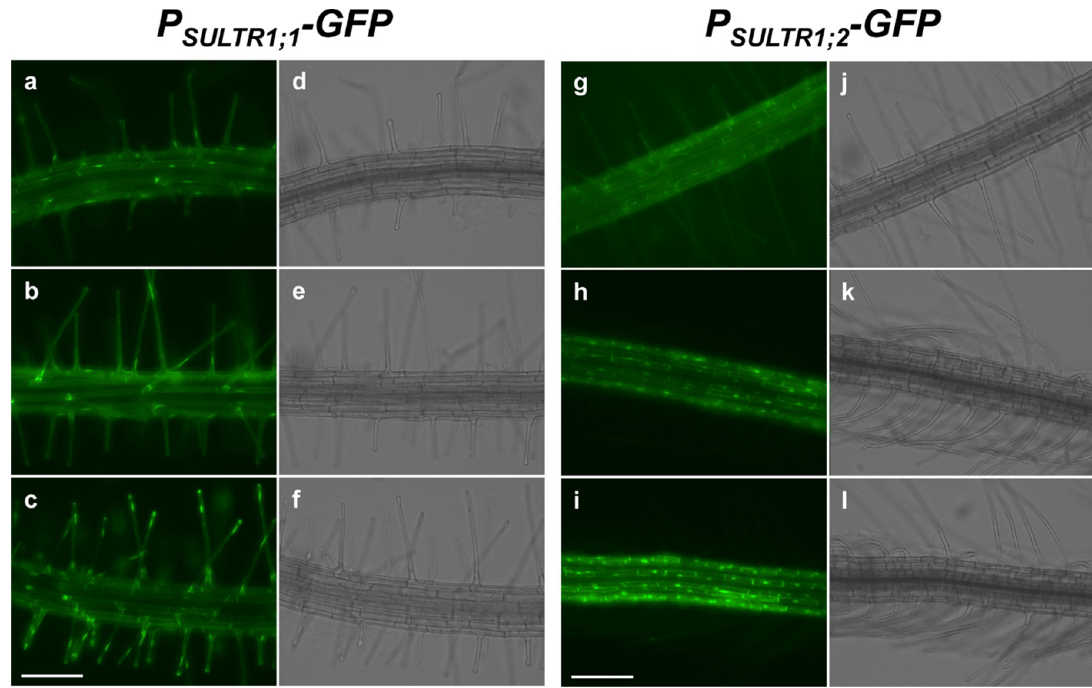
Figure 1. Expression of green fluorescent protein (GFP) in the root elongation zones of P SULTR1;1 -GFP plants ( a – f , [26]) and P SULTR1;2 -GFP plants ( g – l , [27]). Three T 2 generation lines carrying each construct were grown for 7 d on agar media supplied with 15 µM sulfate and observed using fluorescent microscopy (EVOS FL Auto 2). GFP images ( a – c and g – i ) and bright field images ( d – f and j – l ) are presented. Scale bars, 100 µm.